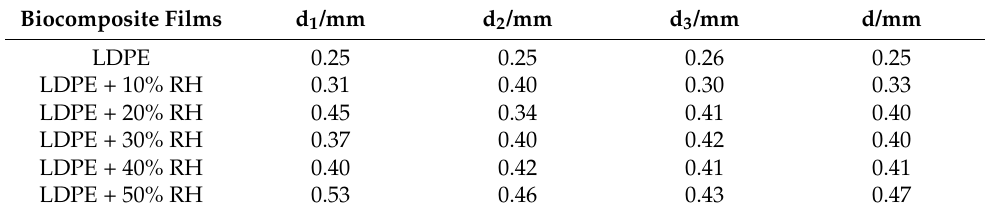
Table 3. Thickness of the LDPE/RH biocomposite